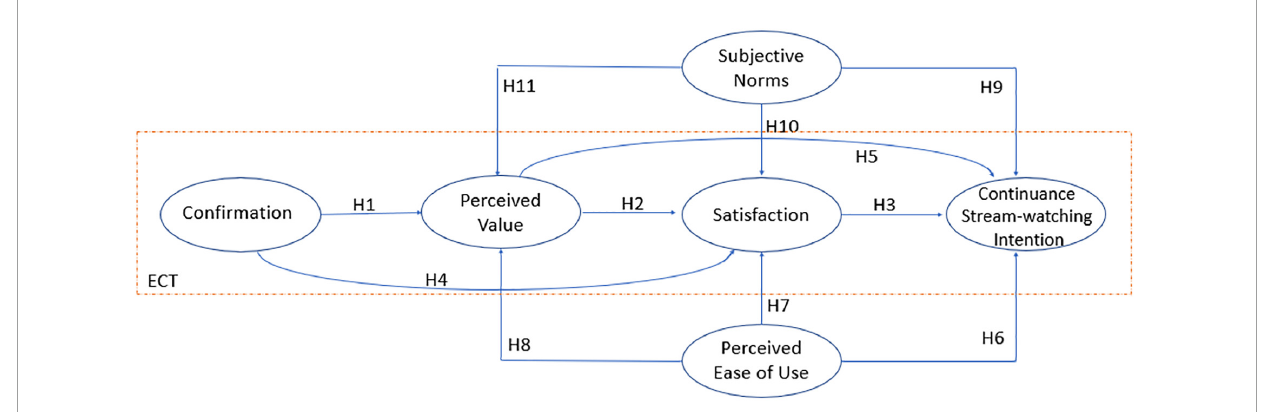
FIGURE2 Proposed V-ECM.